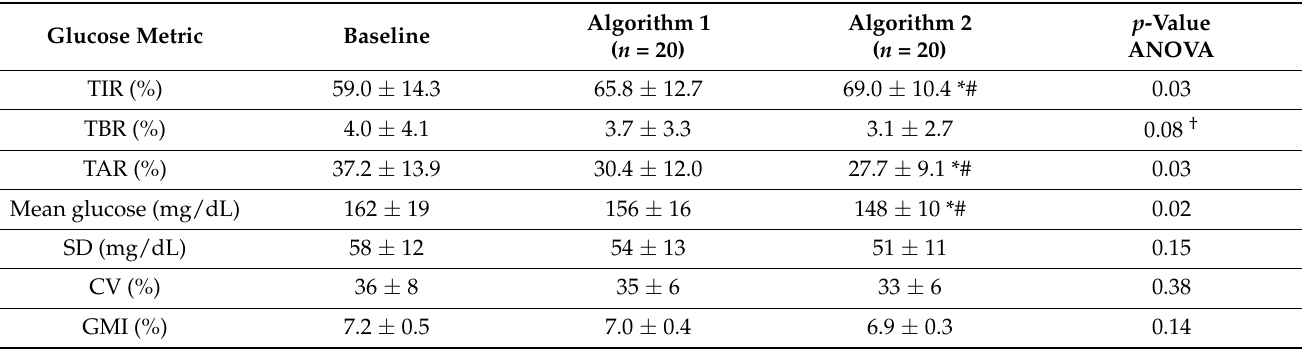
Table 3. Comparison of glucose metrics collected at baseline and after Algorithm 1 (DirectNet/JDRF) and Algorithm 2 (Ziegler).